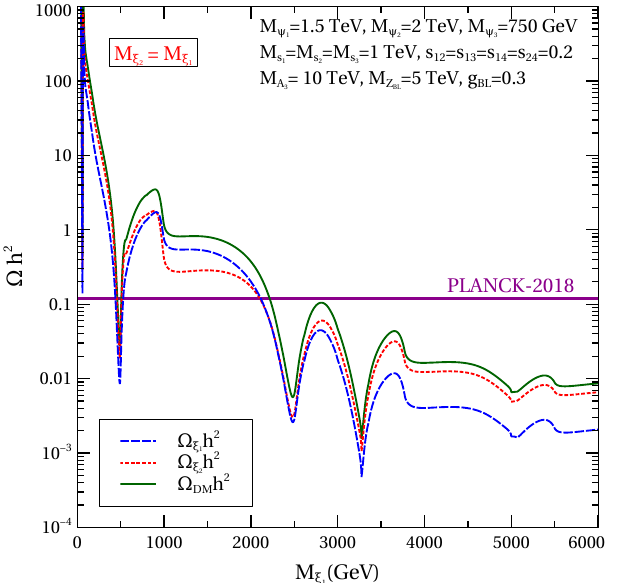
Figure 4 . Relic abundance of two DM candidates with degenerate masses keeping all other model parameters (cid:12)xed to benchmark